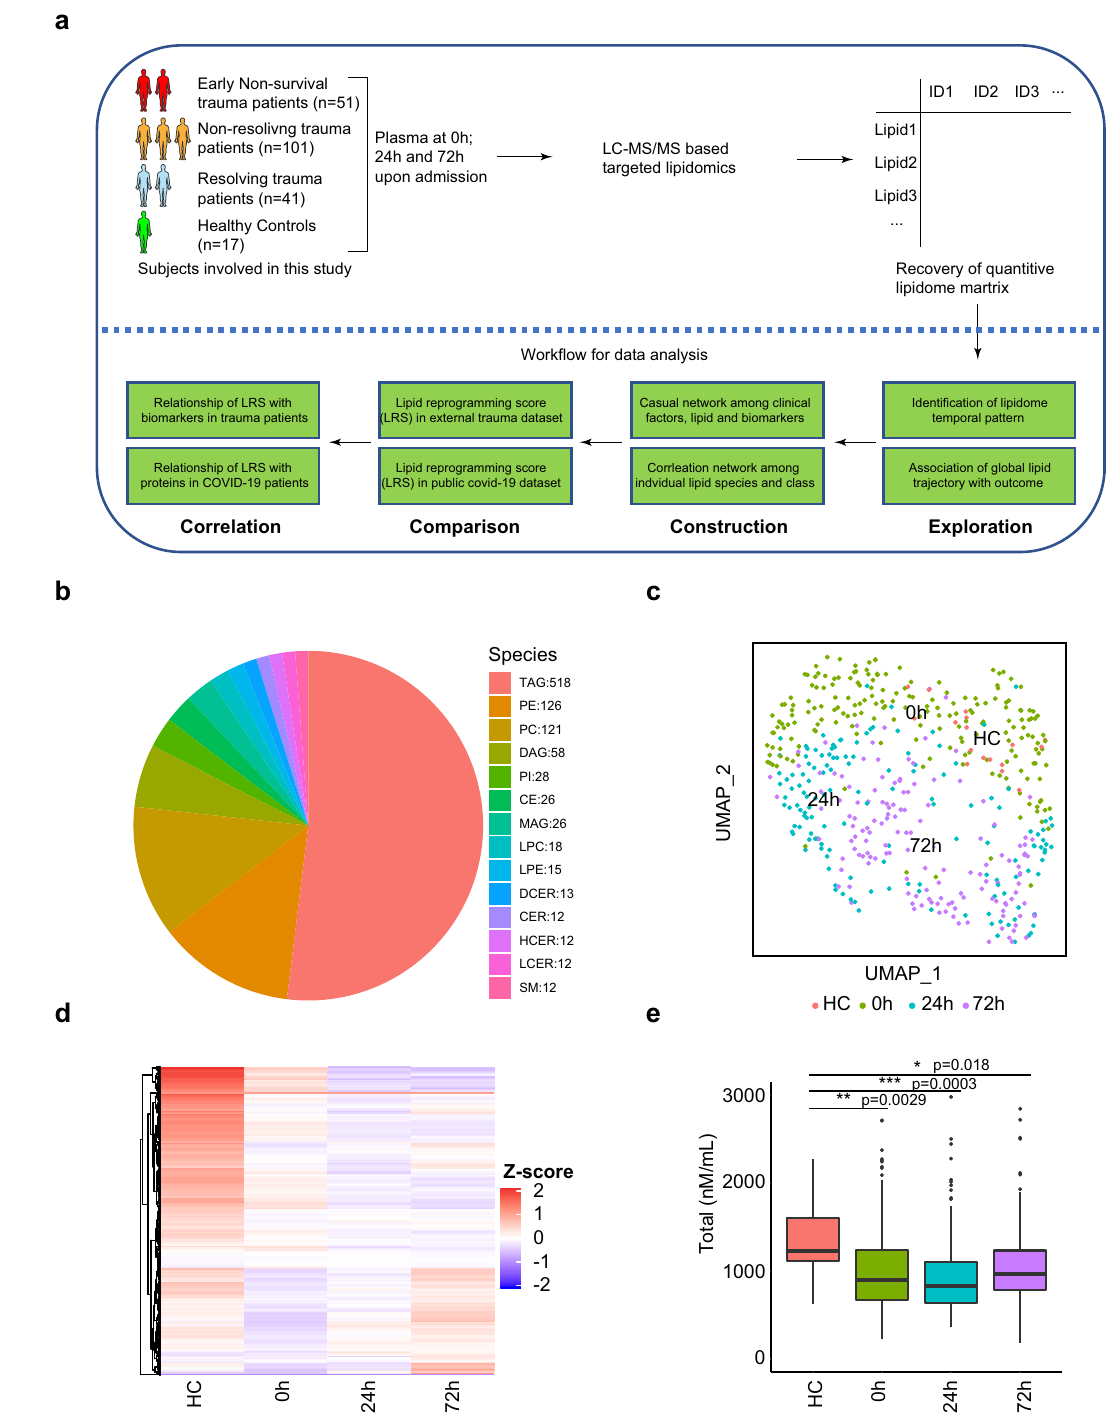
Fig. 1 | Temporal patterns in the circulating lipidome after severe trauma. a Scheme of overall analysis strategy. b Representation of 996 lipid species detected in the lipidomic platform grouped by lipid classes. c Uniform Manifold Approximation and Projection (UMAP) plot shows the distribution of healthy subjects ( n =17) and patients with trauma ( n =193), grouped by sampling time- points(0h,24h,72hafteradmission). d Heatmapshowsrelativelevelsof996lipid species for healthy subjects and trauma patients, grouped by sampling timepoints using z-score normalized concentrations. Lipid species are clustered by Hier- archical clustering. e Quantitative comparison of circulating total lipid concentra- tionamong healthycontrols(HC, n =17)and trauma patients ( n =193), grouped by